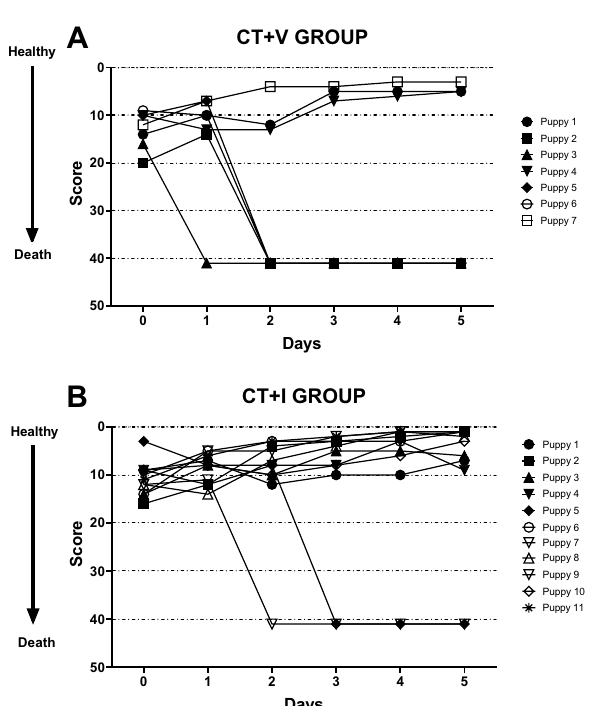
Figure 2. Effect of the immunomodulator over clinical scores of puppies affected by CPE. Clinical score of CT + V ( A ) and CT + I ( B ) across time. Deaths occurred on days 1 and 2 in the CT + V group and days 2 and 3 in CT + I; then, the score of the puppies improved to < 10 in both groups. Each symbol represents a puppy. The score evaluation assigns 0 to the healthy puppy, 21 to high severity state according to Table S1, and, if death occurred, a 20 value was added to accomplish a 41-value score. Kruskal–Wallis test was performed. CT conventional treatment, I immunomodulatory, V